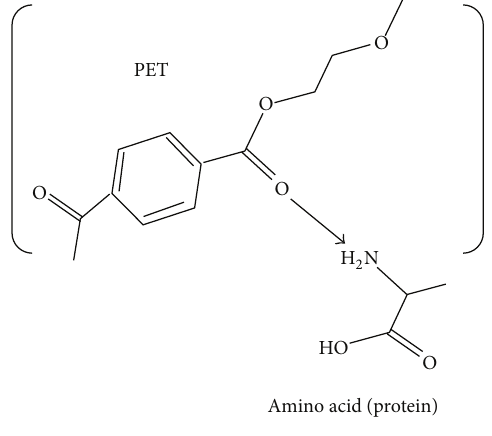
Figure 3: PET-protein chemical